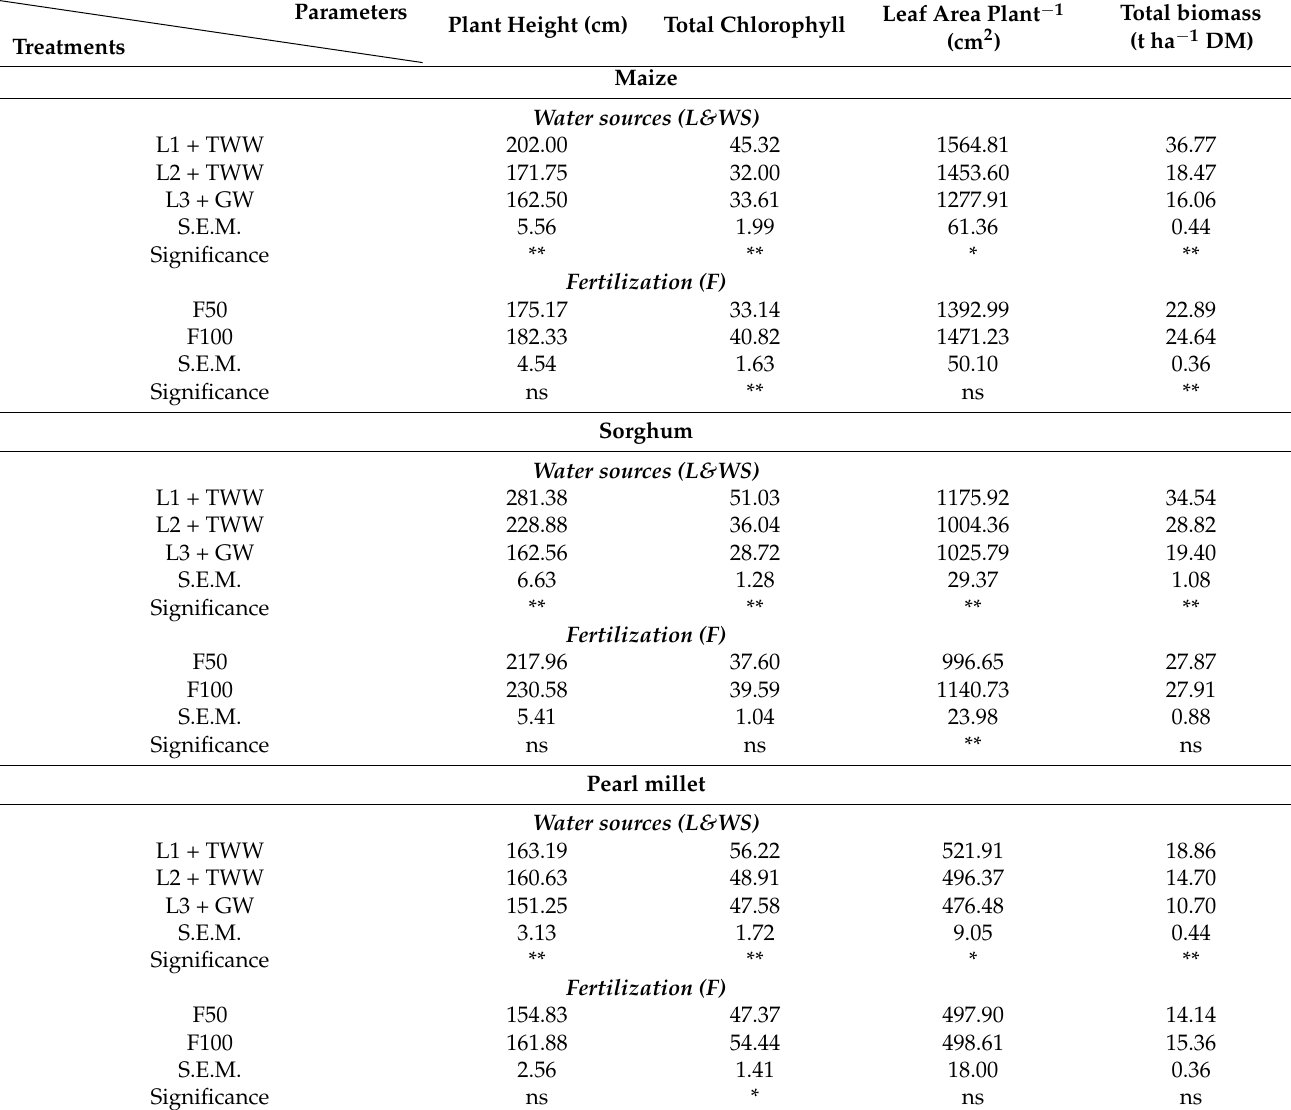
Table 4. Effects of individual factors of water resources and fertilization treatments on growth and total biomass traits of maize, sorghum, and pearl